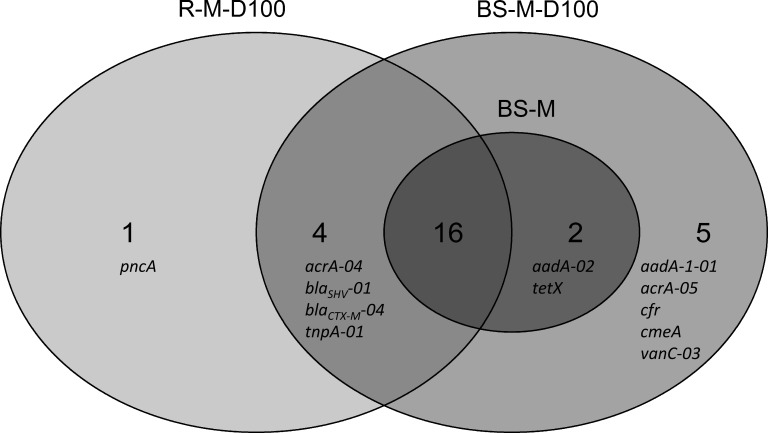
Venn diagram distribution of genes that are enriched on day 42 in the manure and doxycycline-spiked manure treatments (BS-M, BS-M-D100, and R-M-D100) compared to the untreated soil (BS-C), obtained by HT-qPCR.